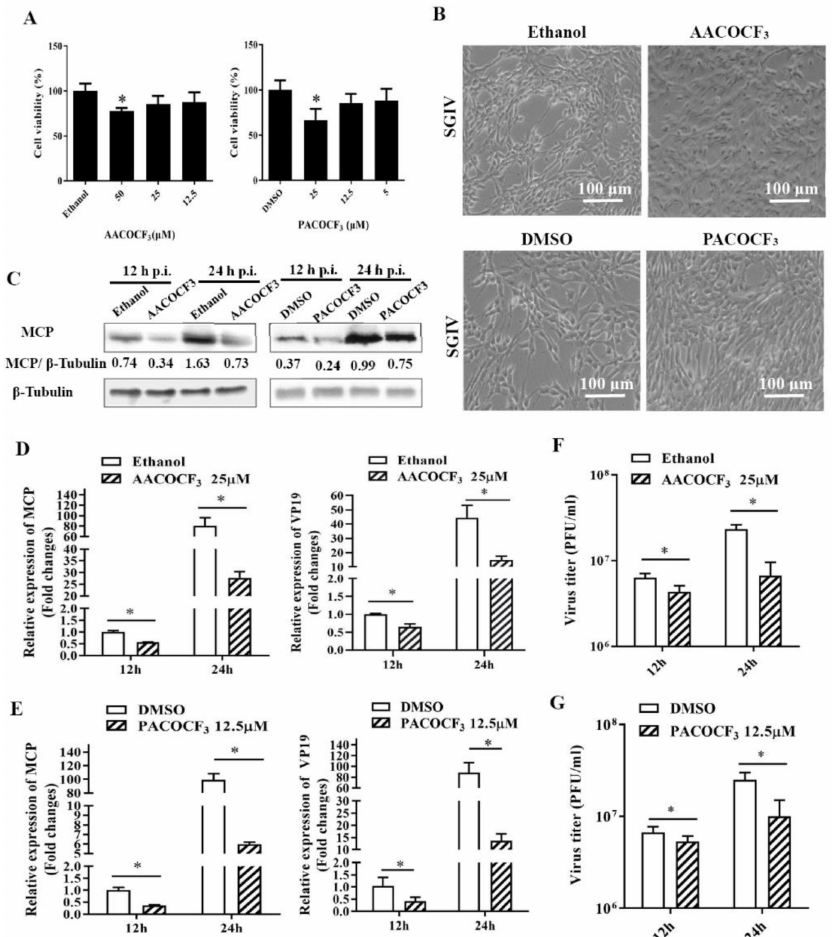
Figure 4. Production of infectious SGIV progeny in cell culture was inhibited by the cPLA 2 inhibitor AACOCF3 or iPLA 2 inhibitor PACOCF 3 . ( A ) The cytotoxicity of AACOCF3 or PACOCF 3 on GS cells was determined using MTT assay. ( B ) The severity of CPE induced by SGIV infection at 24 h p.i. in AACOCF3-treated or PACOCF 3 -treated cells. ( C ) Western blotting analysis of viral major capsid protein (MCP) during SGIV infection in AACOCF3-treated or PACOCF 3 -treated cells. ( D , E ) The effects of AACOCF3 or PACOCF3 on viral gene transcription during SGIV infection. ( F , G ) The effects of AACOCF3 or PACOCF 3 on virus titers during SGIV infection. The asterisks (*) indicated p <